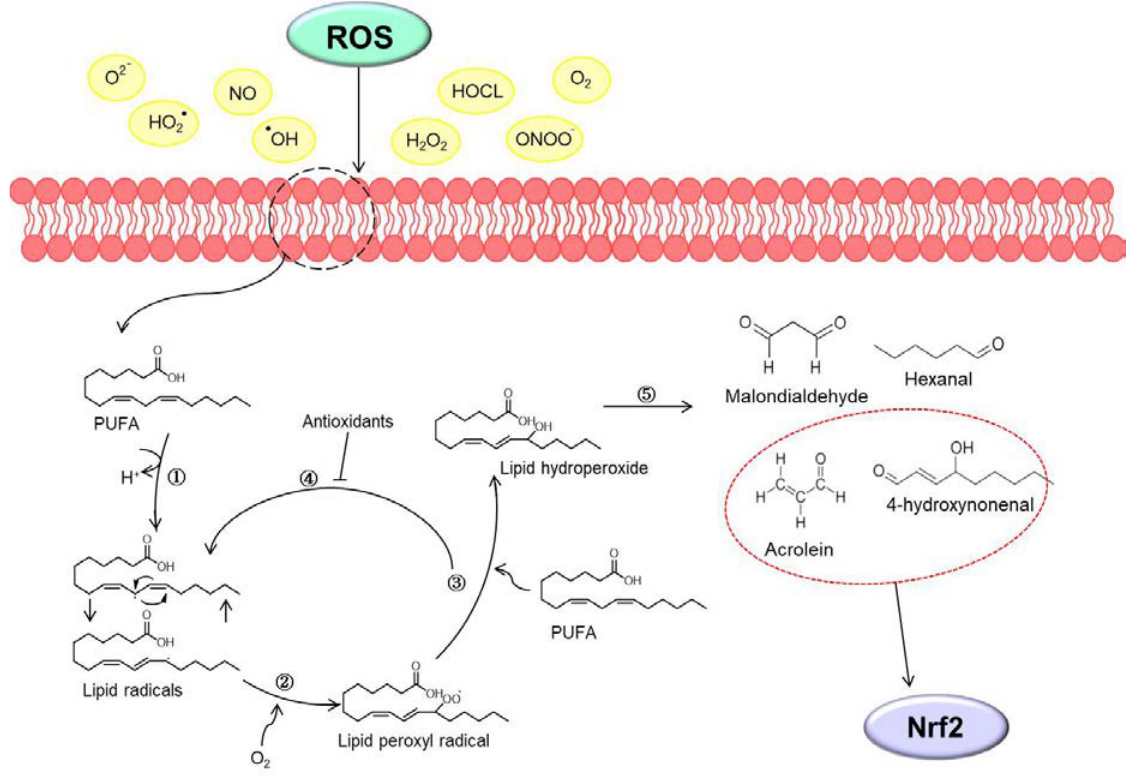
Figure 1. Schematic image of the lipid peroxidation. (1) Initiation phase: reactive oxygen species (ROS) interact with polyunsaturated fatty acids (PUFA), which loses one hydrogen ion and transforms lipid radicals. (2) Propagation phase: lipid radical reacts with oxygen to form (3) lipid hydroperoxide. (4) Termination phase: antioxidants inhibit the propagation stage by donating a hydrogen atom to lipid peroxyl radicals. (5) Finally, lipid hydroperoxide degrades into second oxidative stress messengers such as malondialdehyde, hexanal, 4-hydroxynonenal and acrolein. In particular, 4-hydroxynonenal and acrolein of reactive secondary products interact with the nuclear factor erythroid 2-related factor 2 (Nrf2).